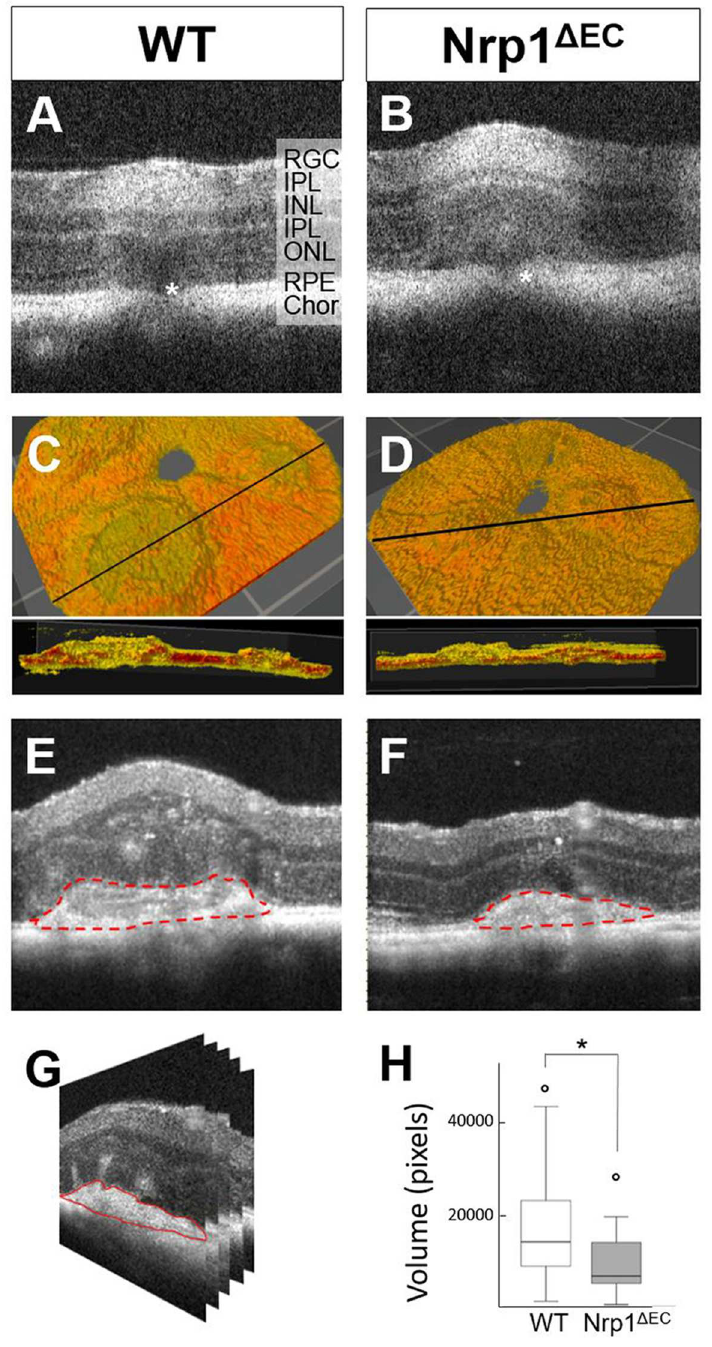
Fig 2. Laser-induced CNV assessedby OCT. In vivo OCT images obtainedimmediately after laser burns were applied,demonstrate Bruch’s membraneruptures (asterisks in A, B) in WT (left column)and Nrp1 Δ EC (right column)mice. One week after laser-induction, CNV lesionswere imaged and quantified (C-H). The top panelsin C, D represent 3D reconstructions of the RPE and CNV lesionsurfaces. The bottom panelsin C, D are cross sections along the black lines in the panels above(red corresponds to white the black and white images and indicatesthe RPE. Dotted red lines in E, F indicatethe lesion borders measured, which were reconstructed into 3D volumes (G) with a distanceof 14 μ m betweeneach frame. CNV volume measurement box-plots show significantvolume reductionin Nrp1 Δ EC comparedto WT mice (P < 0.05;n = 7). RGC: Retinal GanglionCell; IPL: Inner Plexiform Layer; INL: Inner NuclearLayer; OPL: Outer Plexiform Layer; ONL: Outer NuclearLayer; RPE: RetinalPigment Epithelium; Chor: